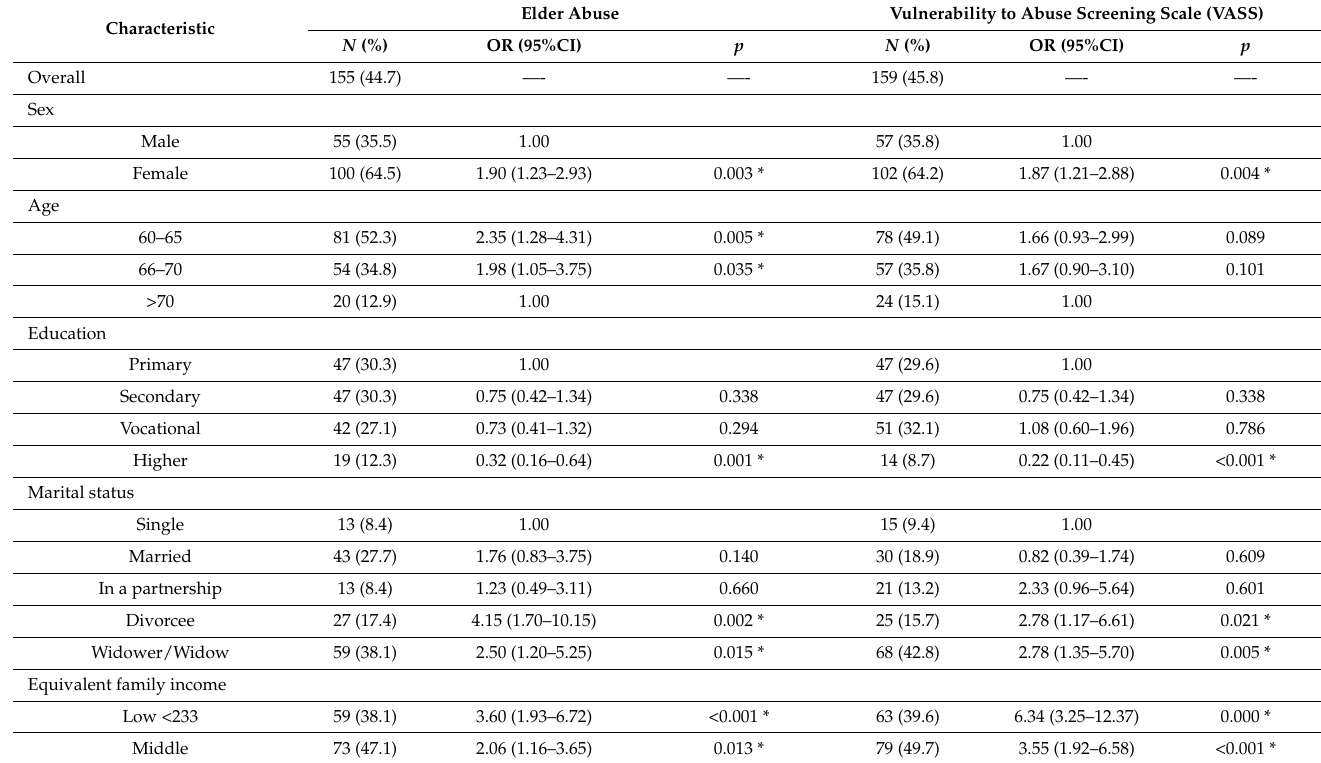
Figure 1. Type of elder abuse. Table 2. Logistic regression analyses of factors associated with elder abuse and vulnerability to abuse screening scale